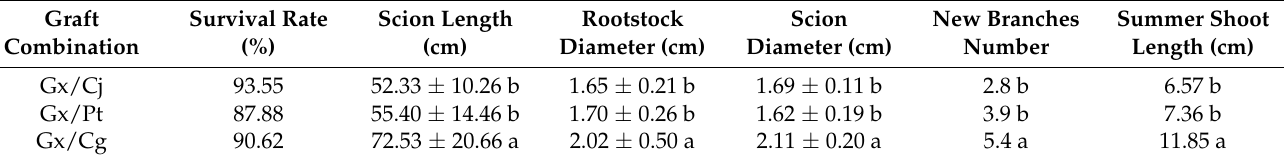
Table 1. The growth indexes of ‘Guanxi Miyou’ grafted onto three citrus rootstocks on 139 DAG.